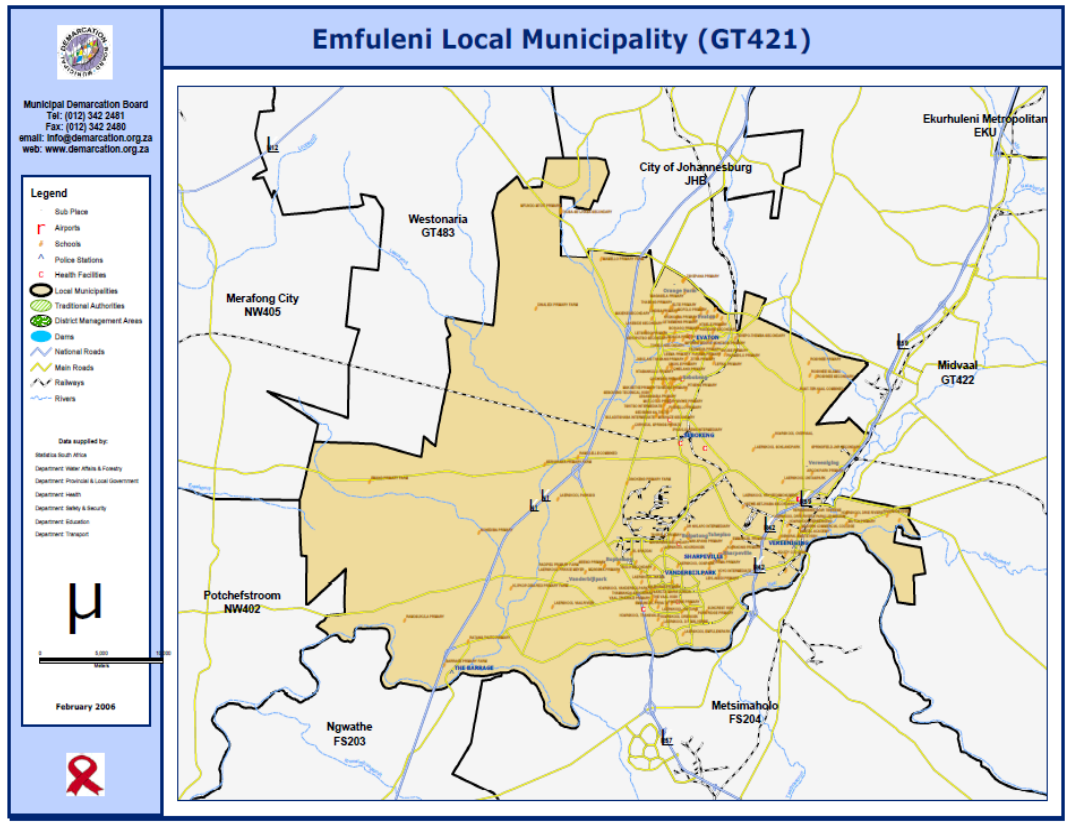
Figure 2 Boundaries of the Emfuleni local municipality(Source: Municipal Demarcation Board http://www.demarcation.org.za